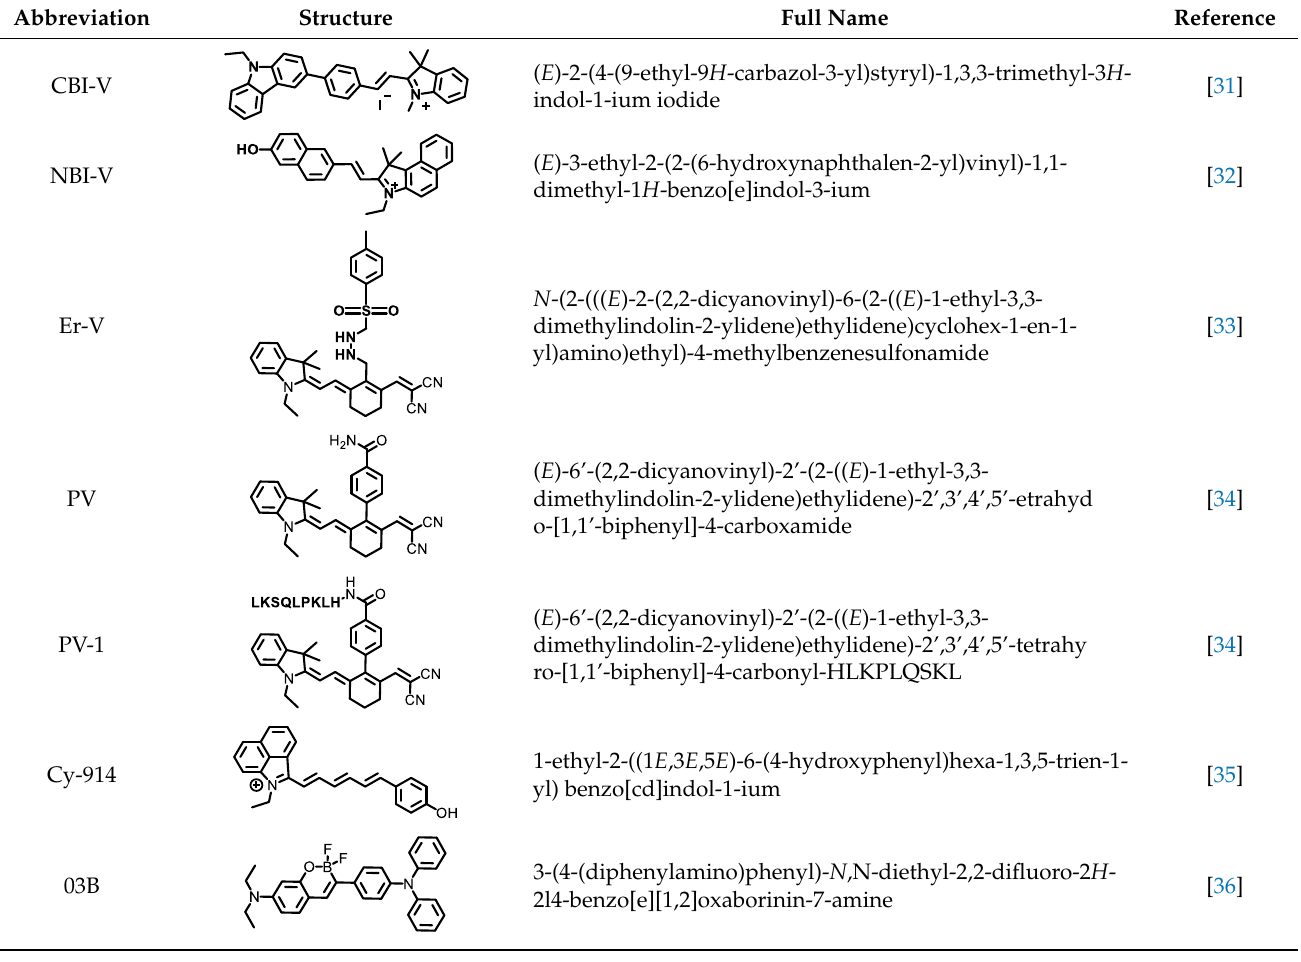
Figure 1. A brief illustration showing stimuli-responsive fluorescence probes for fatty liver. Table 1. Full names of abbreviations for representative fluorescent molecules in the text.